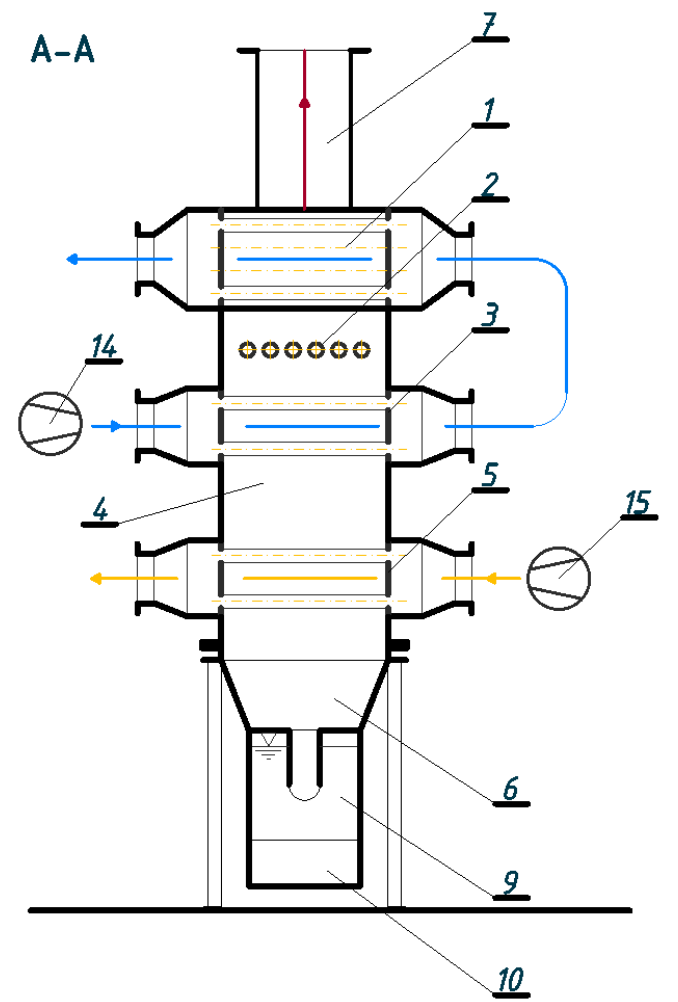
Figure 2. A diagram of the installation for fuel savings, combustion gas cleaning and heat and water recovery from combustion gases produced in combustion chambers—cross-section A-A (markings as in Figure